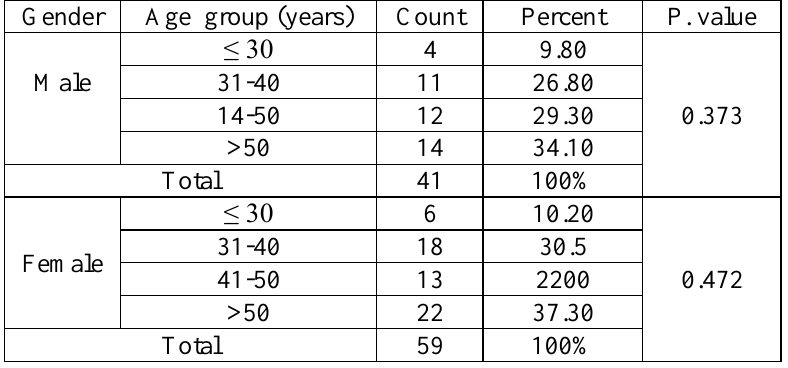
Table 4: Gender by cross-over sign cross tabulation on radiographs among study patients Gender